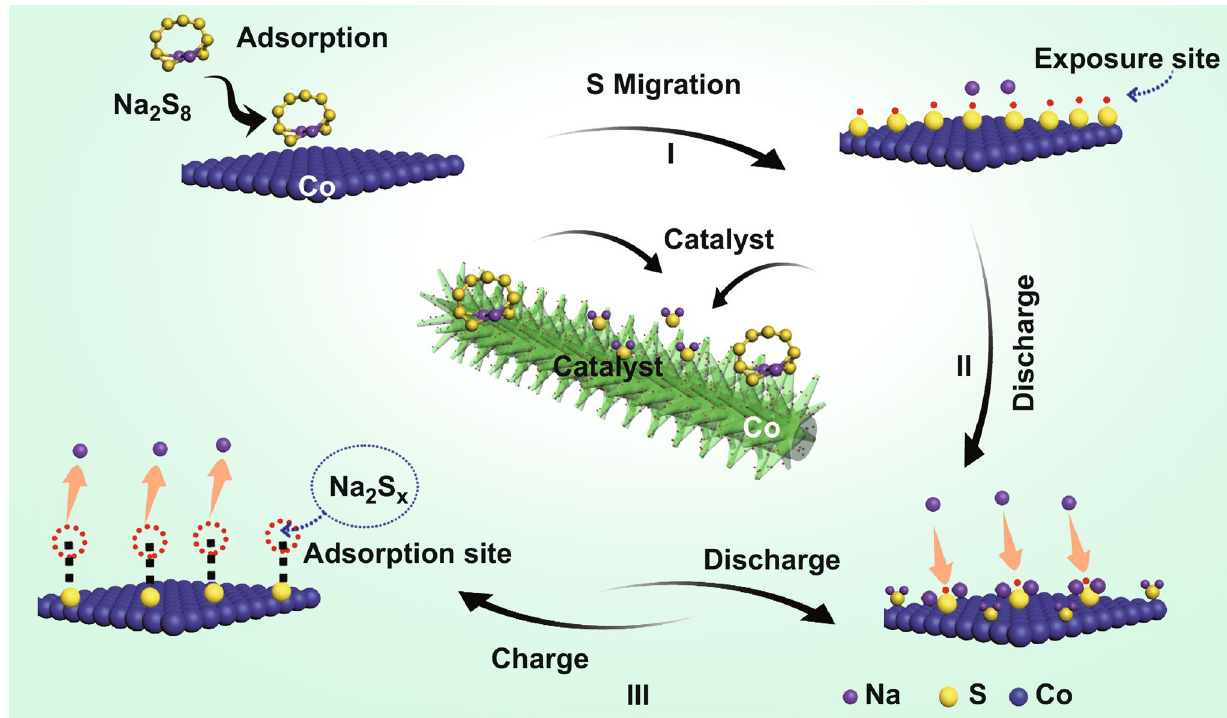
Fig. 5 Mechanism for enhancing the Na–S battery